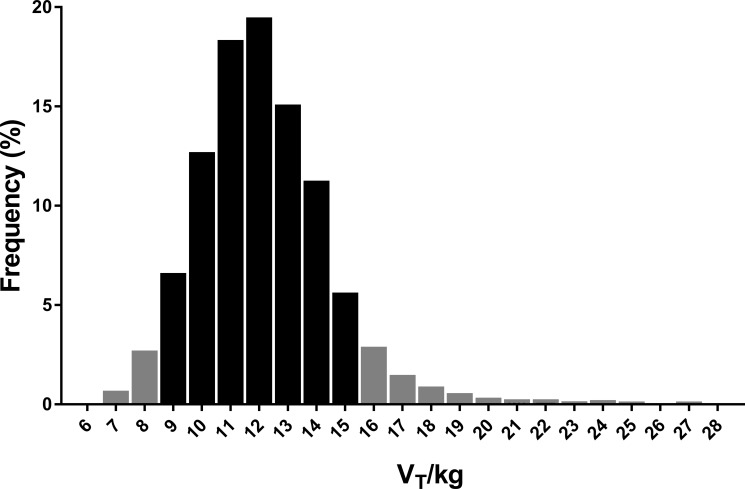
Distribution of tidal volumes (VT) observed in subjects with cystic fibrosis.Eighty percent of subjects had a VT within 9–15 ml/kgIBW (ideal body weight). There were 9 trials with a VT/kg > 28mL/kg but are too few to be visible.